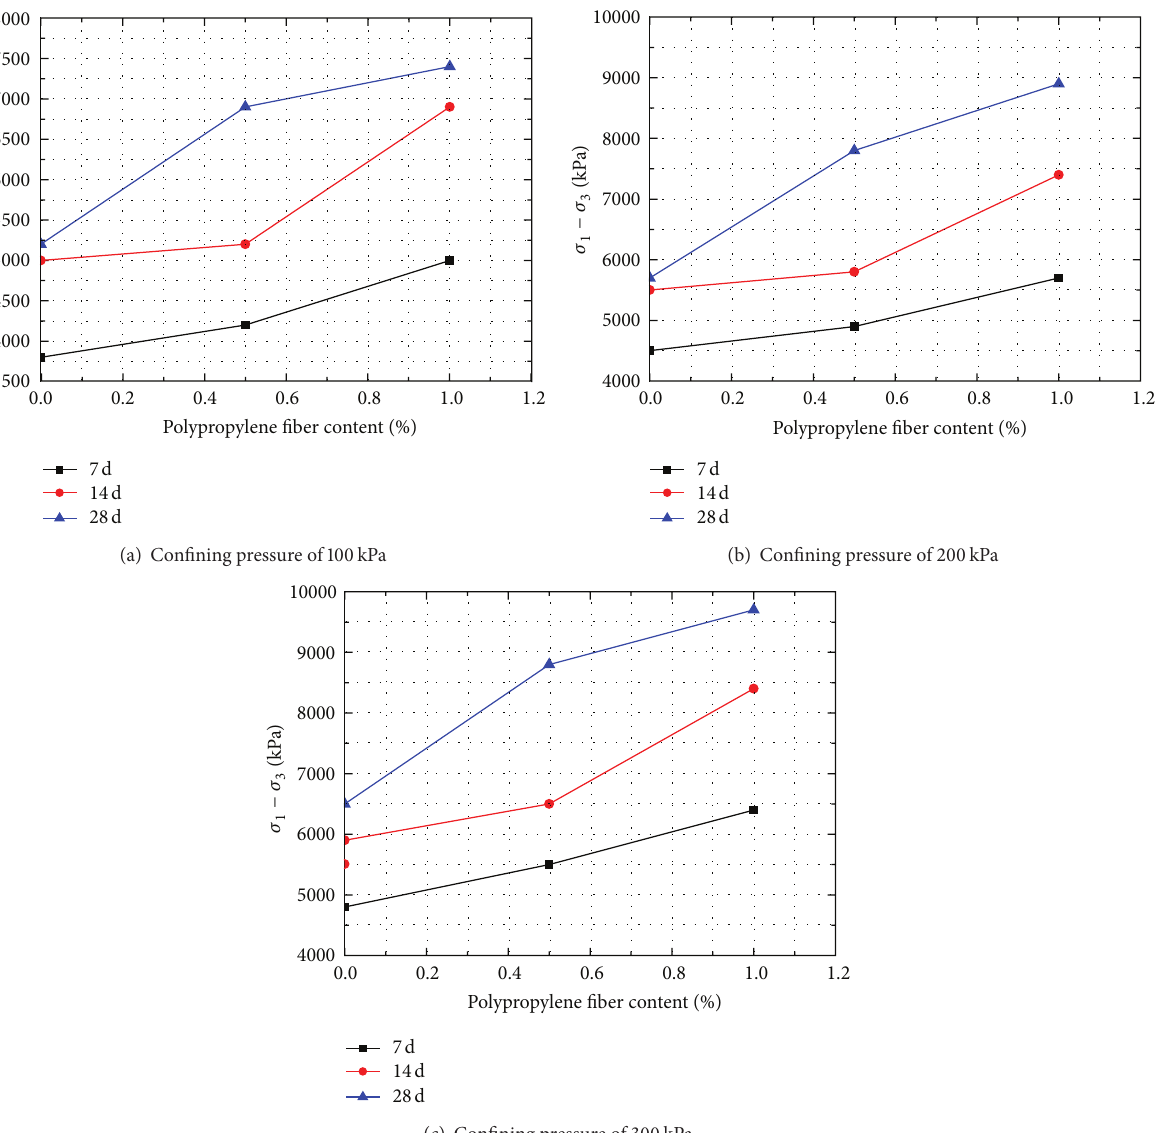
Figure 6: The limit deviatoric stress change with dosage under different confining pressure.